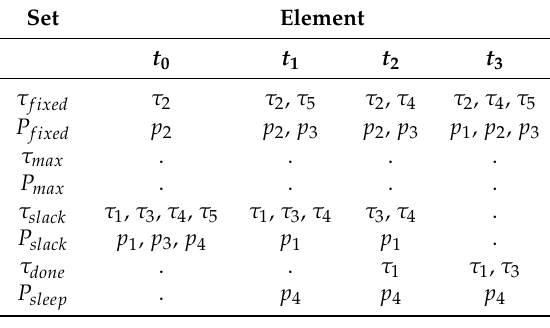
Table 10. Example of sets at events in the plane.